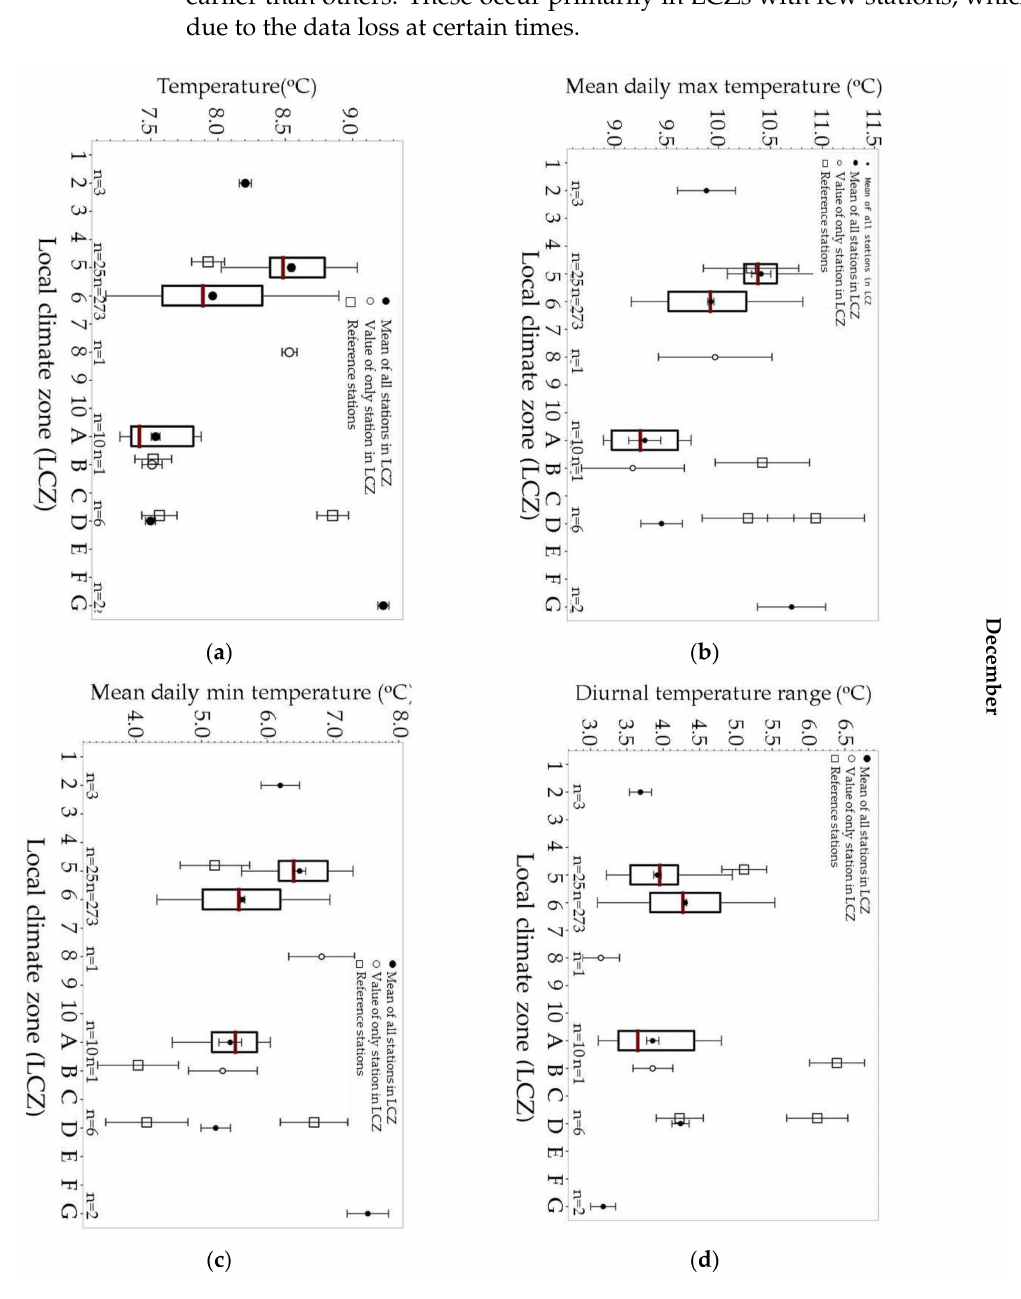
Figure 6. As for Figure 5 but for December